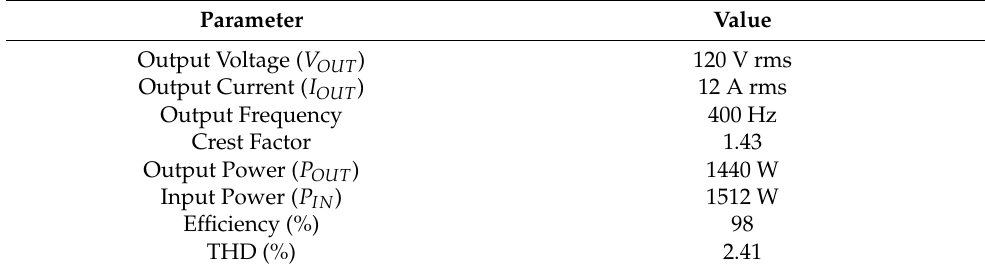
Figure 15. Proposed half-bridge inverter output waveforms are shown in Typhoon HIL SCADA. The top left corner is the output voltage ( Va 1 ), the top right corner is the DC link inductor currents ( L 1 , L 2 ), the bottom left corner is the inverter output current ( Ia 1 ) and the bottom right corner is the output power. Table 4. Proposed half-bridge 400 Hz CSI HIL parameters.